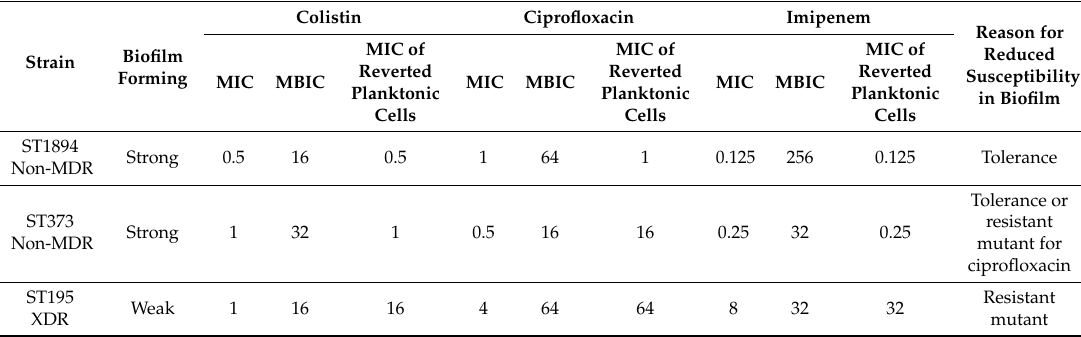
Table 7. Reversibility of antibiotic resistance of biofilm cells.